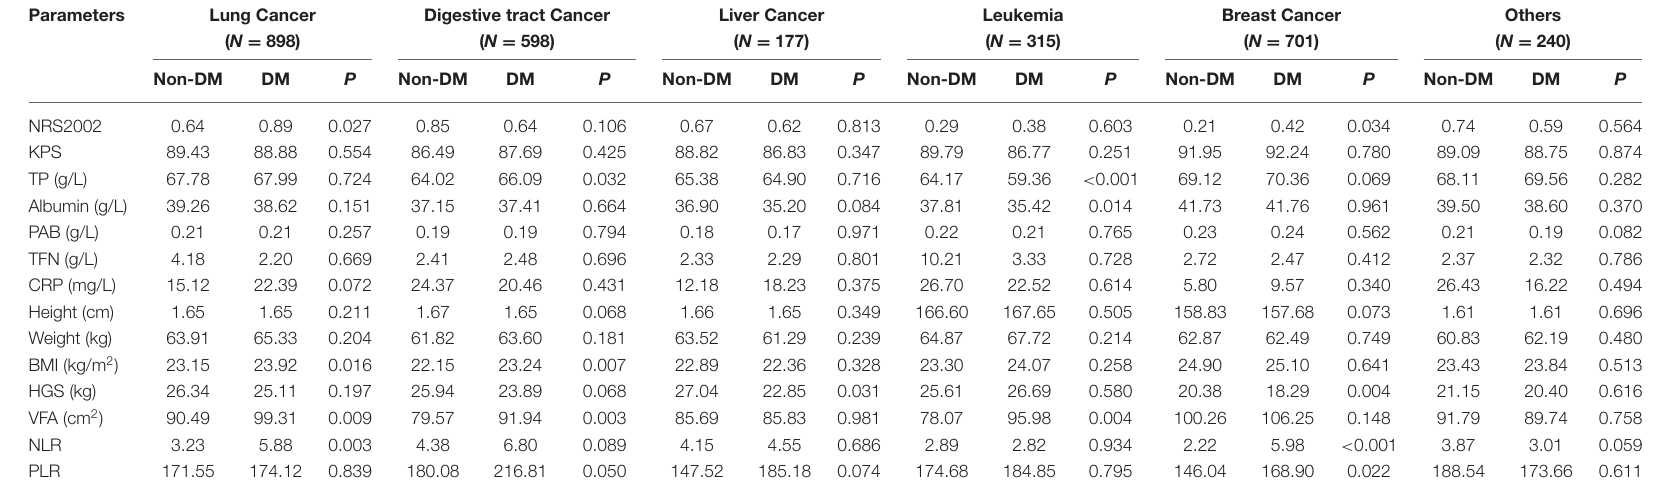
TABLE 2 | Basic clinical information for all involved patients stratified by DM. Parameters